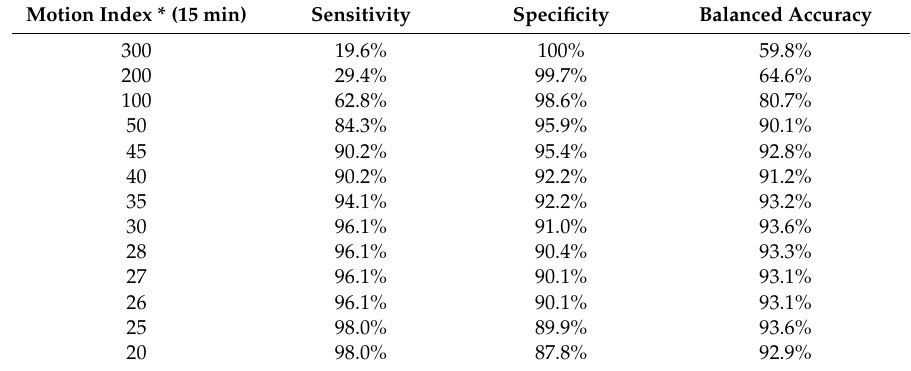
Table 4. Sensitivity and specificity calculations for selected motion index cut points for 15 min sampling intervals (number of sample points =